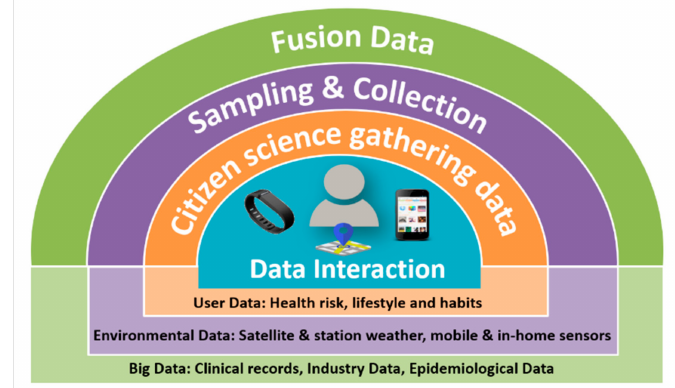
Figure 1. Four-step methodological